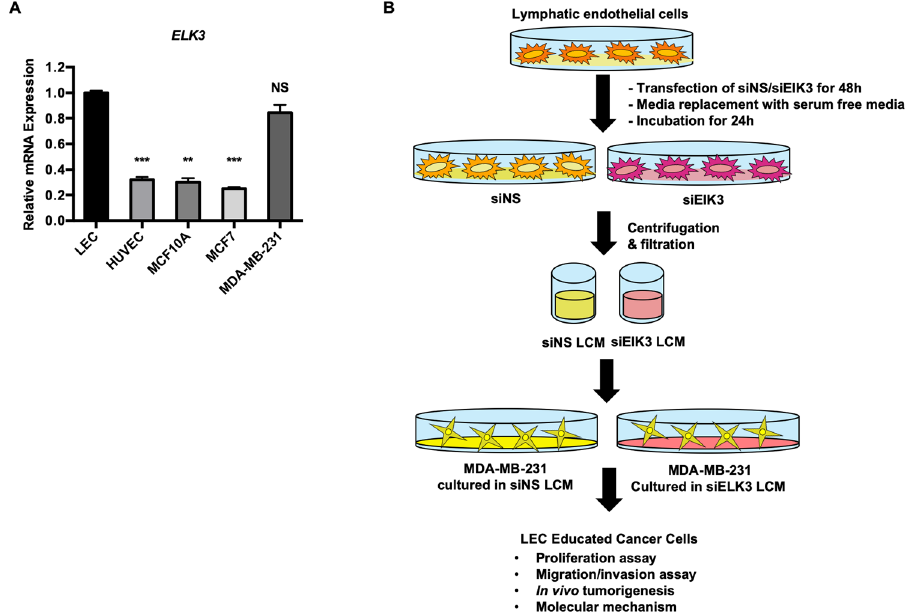
Figure 1. LCM educated tumor model model to study the effect of ELK3 expression levels on the secretome of LECs. ( A ) The relative expression of ELK3 in LECs was compared with that in breast cancer cells by qRT- PCR. ( B ) For the LEC-tumor education model, LCM was prepared from LEC culture. LECs cultured in EBM-2 medium were transfected with nonspecific siRNA (siNS) or an siRNA targeting ELK3 (siELK3) for 24 h, and the cells were further cultured in SFM for 24 h to allow the factors secreted by LECs to accumulate. The medium collected at this time is referred to as siNS LCM or siELK3 LCM, and 30% or 70% LCM coculture medium (LCM: DMEM = 3:7 or 7:3) was applied to MDA-MB-231 cells to educate the cancer cells. Error bars represent the standard error from three independent experiments, and each experiment was performed using triplicate